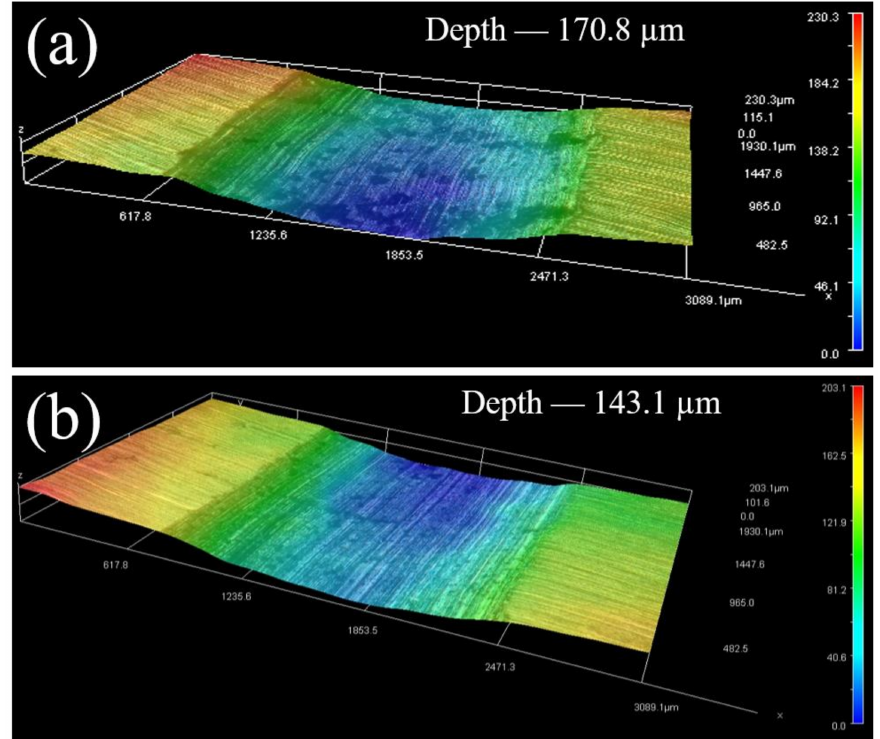
Figure 5. Three dimensional microscope images of the worn surface of ( a ) AZ31 and ( b ) AZ31/WS 2